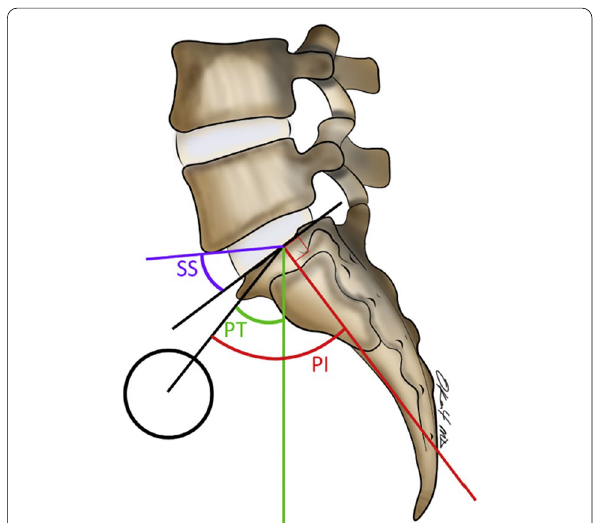
Fig. 3 PT (green line) is defined as the angle between the vertical reference line and the line connecting the femoral head to the midpoint of the sacral plate. PI (red line) is defined by the angle between the line perpendicular to the sacral plate midpoint and another line connecting the sacral plate midpoint to the femoral head. SS (purple line) is the angle formed between the sacral endplate and the horizontal reference line [5]